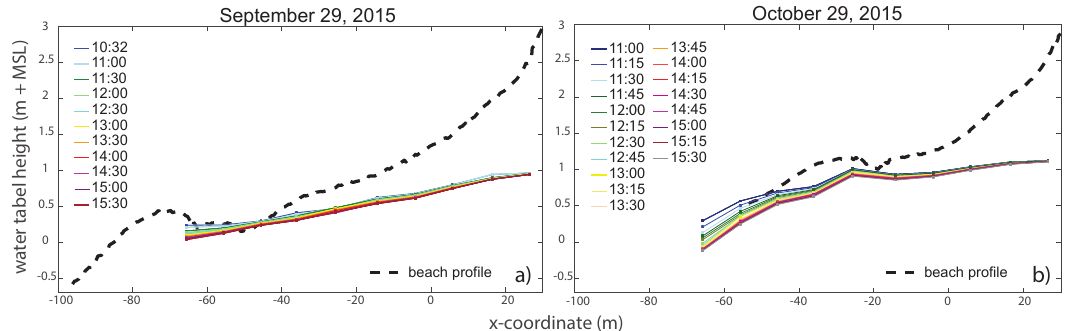
Figure 10. Groundwater levels over a cross-shore transect during falling tide on ( a ) 29 September and ( b ) 29 October 2015. The different colors show different moments in time. At each time step a corresponding surface moisture map by the TLS was taken.